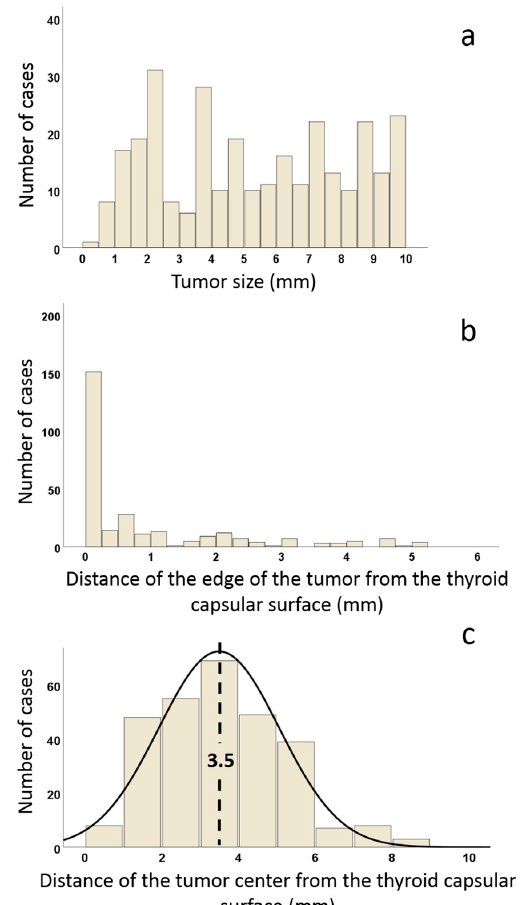
Figure 2. Distribution of cases according to tumor size ( a ), to the distance of the edge of the tumor from the thyroid capsule ( b ), and according to the distance of the tumor center from the thyroid capsule ( c ). The median distance of the tumor center from the thyroid capsule is 3.5 mm (range 0.5–11 mm). Table 1. Clinicopathologic characteristics (Total: 286 mPTCs).